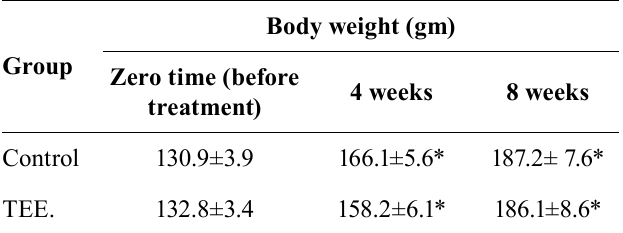
TABLE (I) – Effect of long term administration of daily